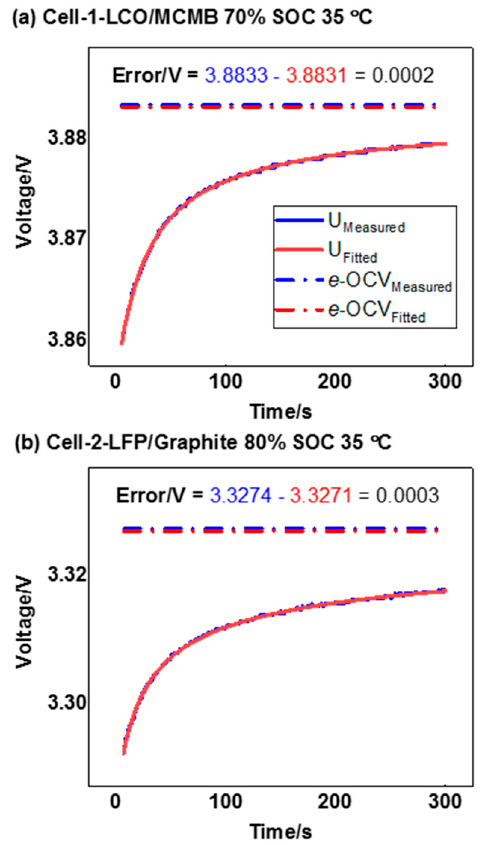
Figure 4. The measured and predicted voltage relaxation results of: ( a ) LCO/MCMB battery (Cell-1) at 70% SOC, and ( b ) LFP/Graphite battery at 80% SOC. They were discharged with 0.5 C at 35 °C before the current interruption. Table 3. Specifications of the validation results of LCO/MCMB battery (Cell-1) at different